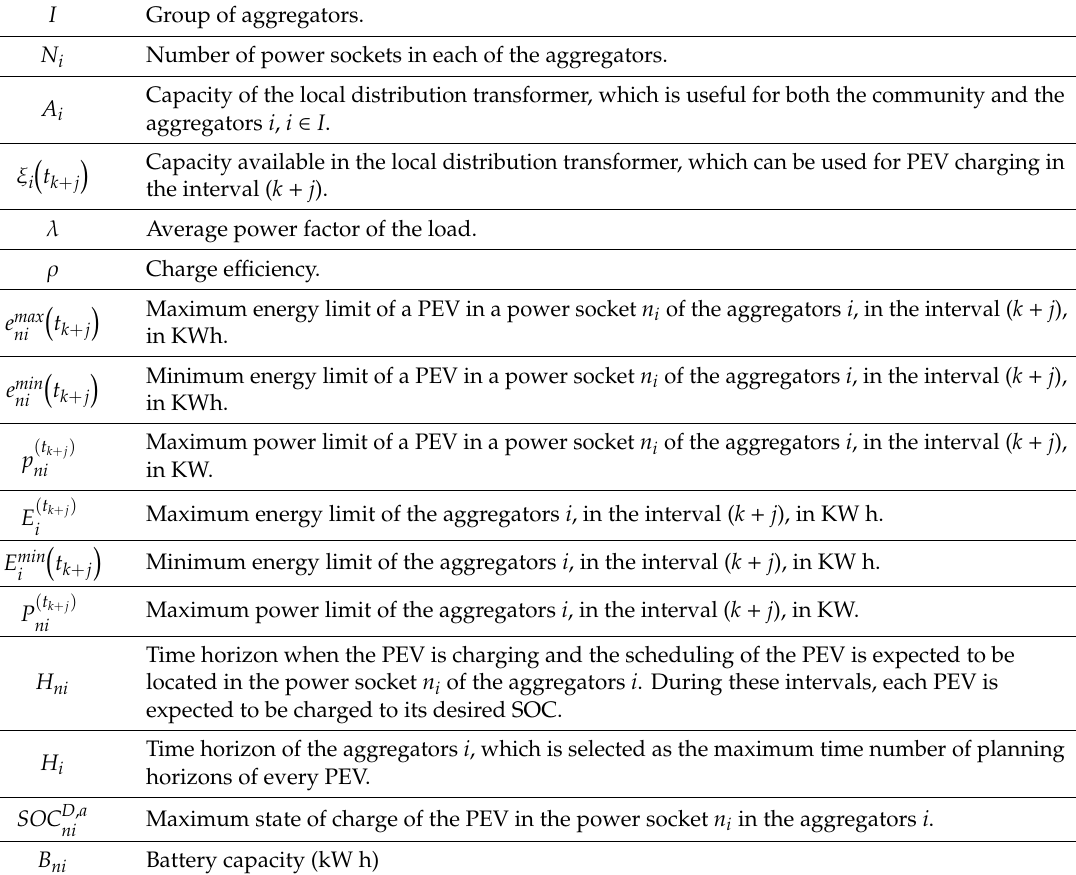
Table 1. Notations of operation cost of electric